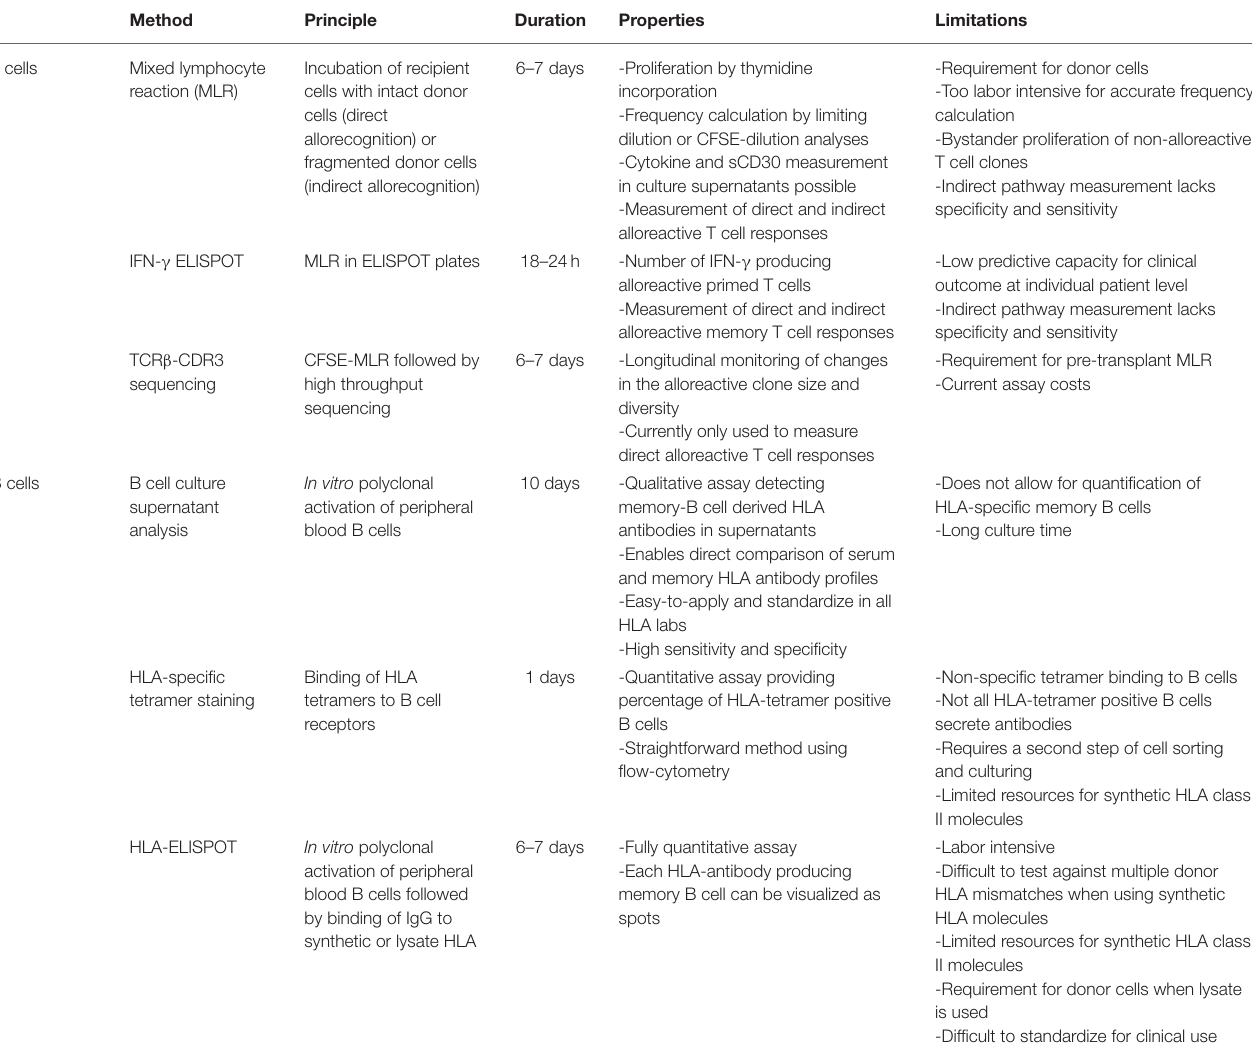
TABLE 1 | Overview of methods to detect alloreactive T and B